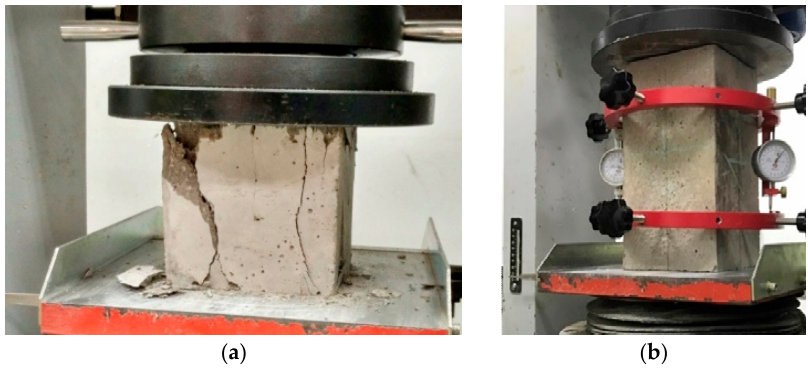
Figure 2. ( a ) Concrete cubic specimen compressive testing; ( b ) Young’s modulus tests for prisms specimens.